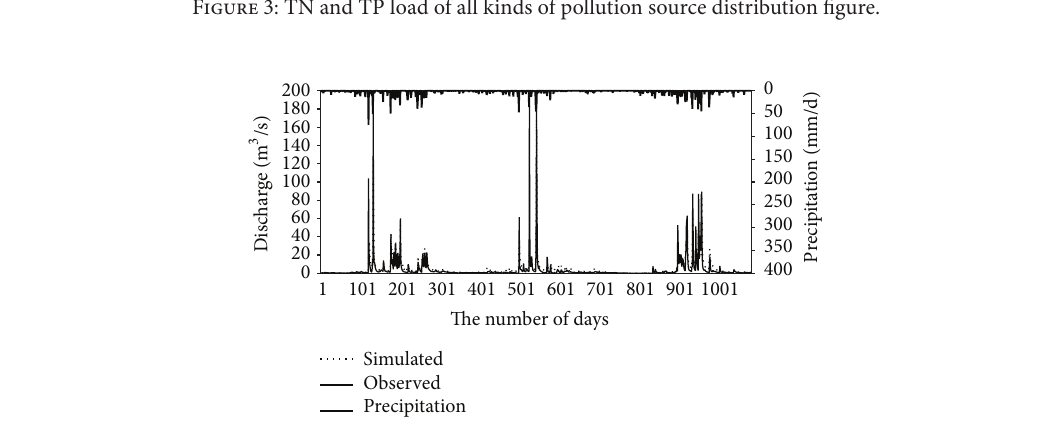
Figure 3: TN and TP load of all kinds of pollution source distribution figure.